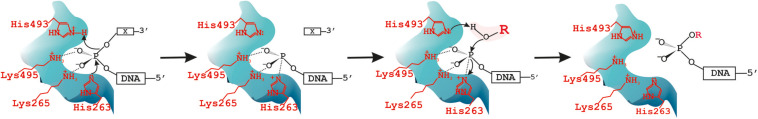
Tyrosyl-DNA phosphodiesterase 1 (TDP1) catalytic cycle: it catalyzes not only hydrolysis but also transferring reaction. X = DNA 3′-end modification [non-nucleotide insertion (Figures 1, 2, 5) or black hole quencher (BHQ) (Supplementary Figure S2B) or glycerol/alcohol (Figure 2)]. R = H in the case of hydrolysis reaction or alcohol: C2H5-, -C2H4OH, OHCH2-CH(OH)-CH2- in the case of transferring reaction catalyzed by TDP1–“transphosphooligonucleotidation.”